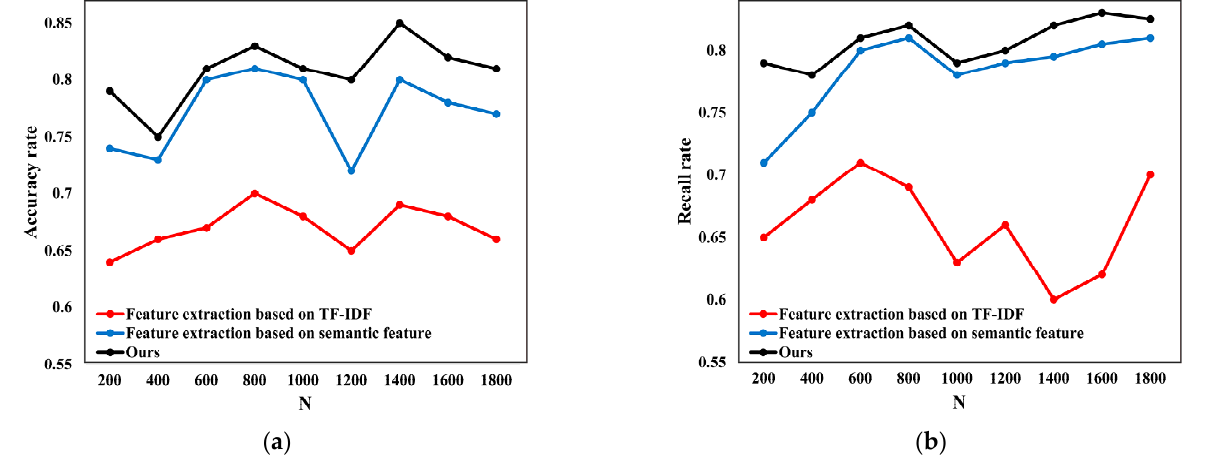
Figure 2. Comparison of different feature extraction algorithms: ( a ) Accuracy comparison; ( b ) Recall comparison.